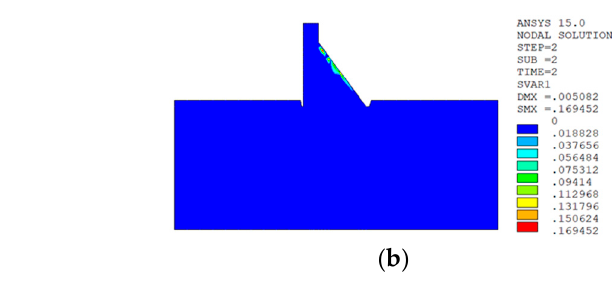
Figure 24. The cloud charts of the three principal strains on the section z = 21 m are calculated by the macro model under the temperature drop condition, ( a ) The cloud chart of the first principal strain, ( b ) The cloud chart of the second principal strain, ( c ) The cloud chart of the third principal strain.